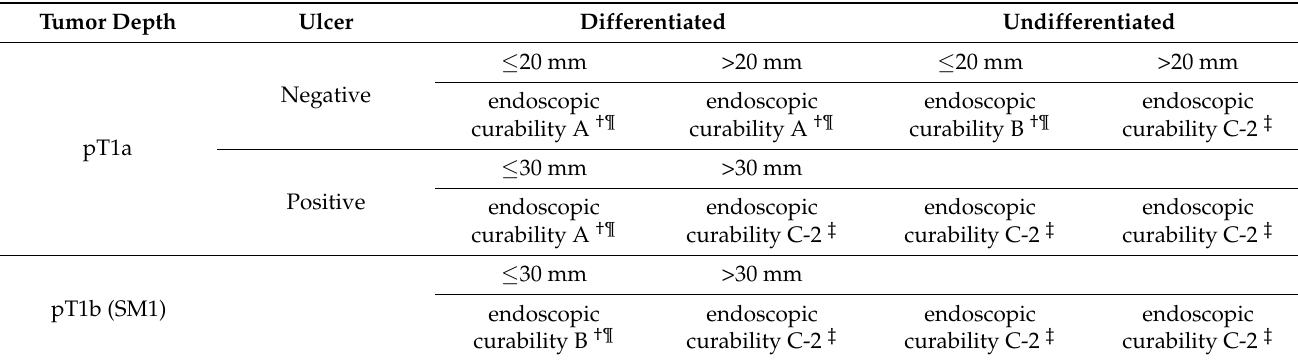
Table 1. The curability of endoscopic resection in the Japanese gastric cancer treatment guidelines 2018, 5th edition. Tumor Depth Differentiated